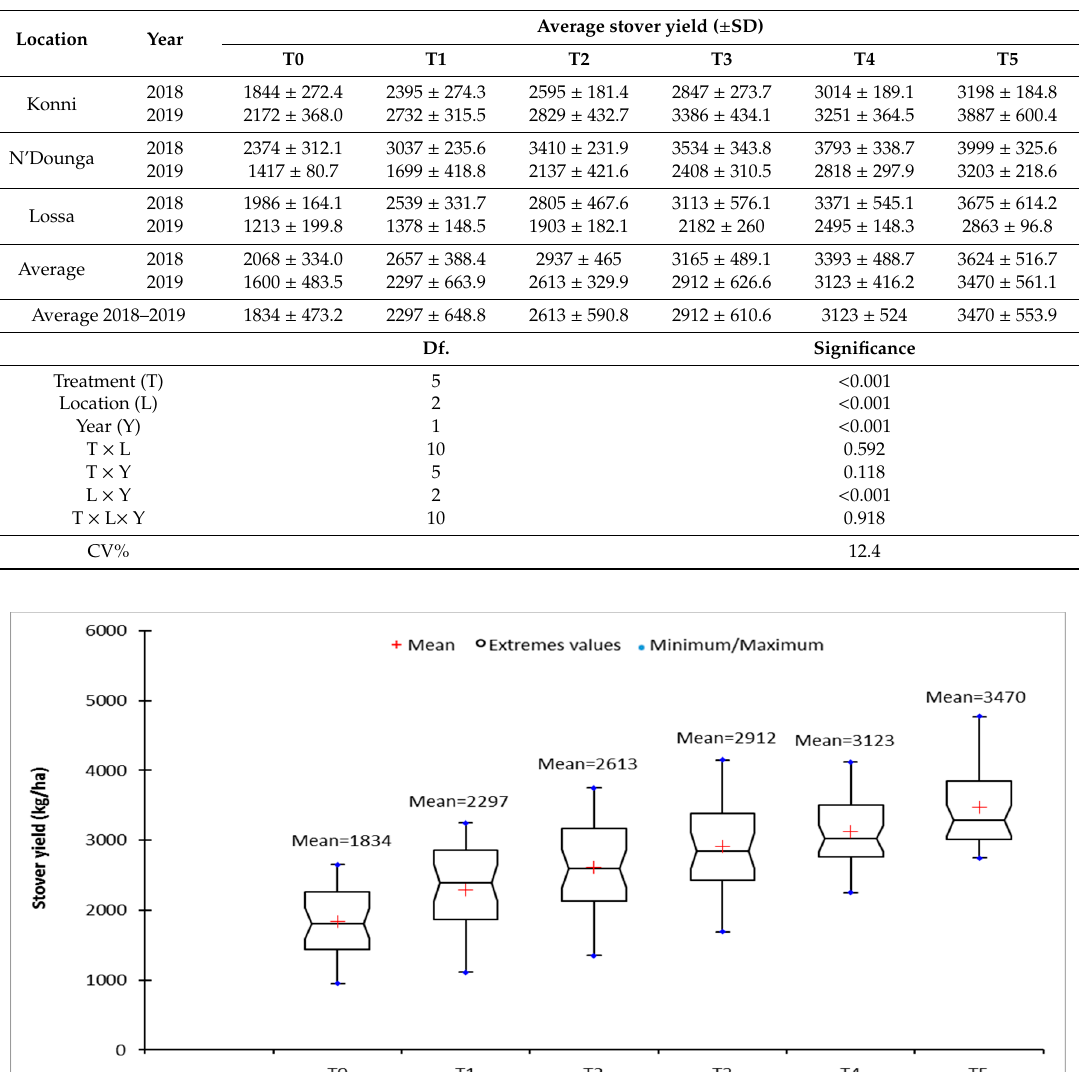
Table 6. E ff ects of treatments on pearl millet stover yield (kg ha − 1 ). Averages of treatments and corresponding 95% confidence intervals are presented.